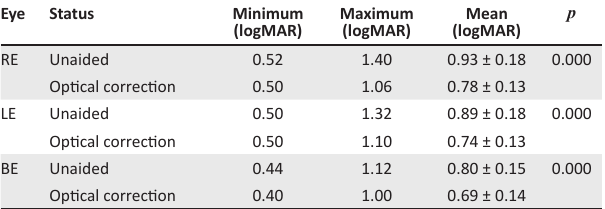
TABLE 2: LogMAR distance visual acuity without and with optical correction.